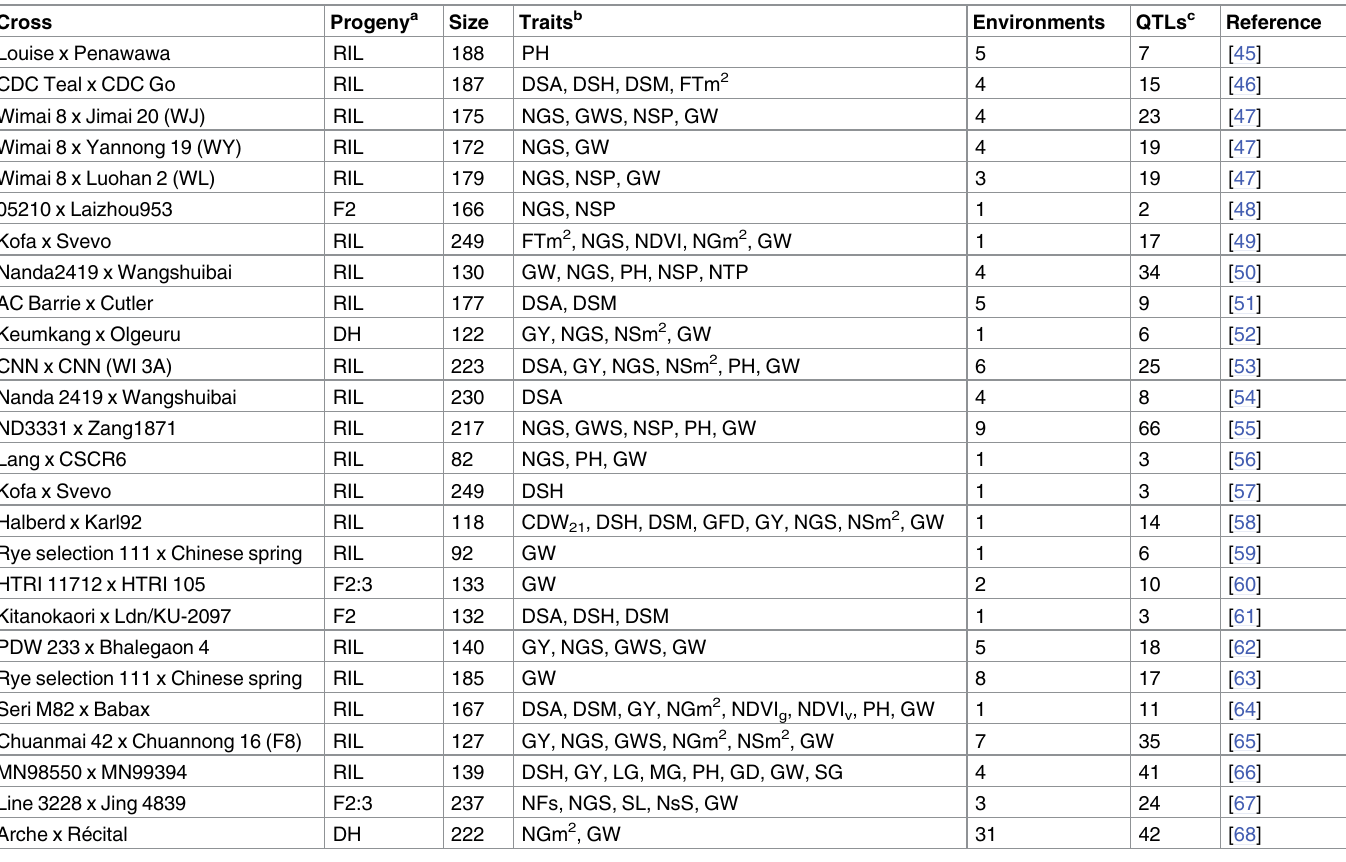
Table 3. Summaryof QTL studies included in the